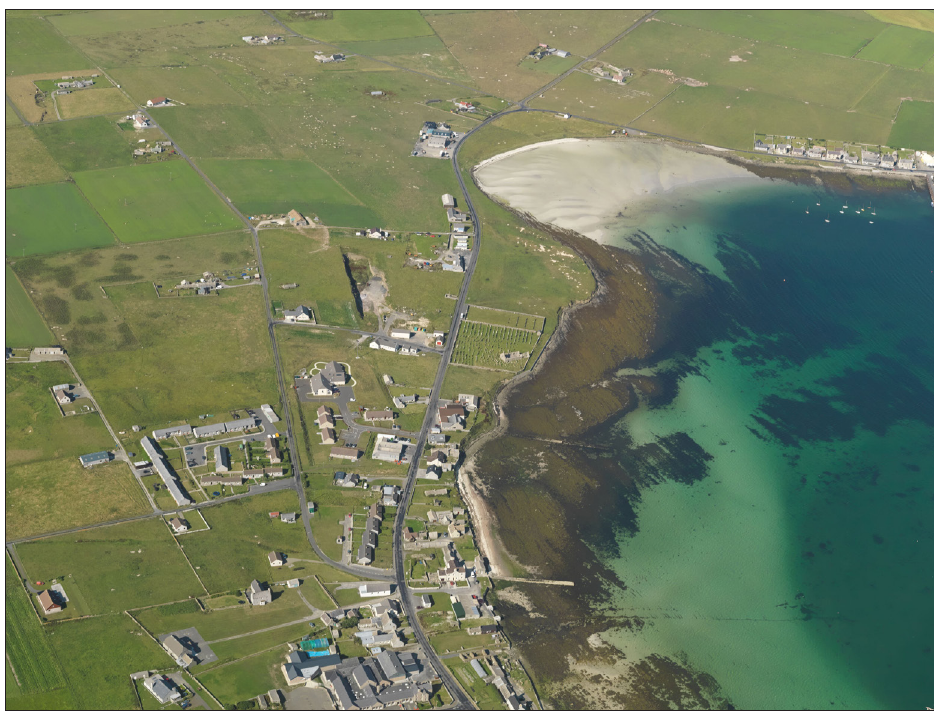
Figure 2: Aerial photograph of Sands of Gill and Pierowall village, Westray. ©